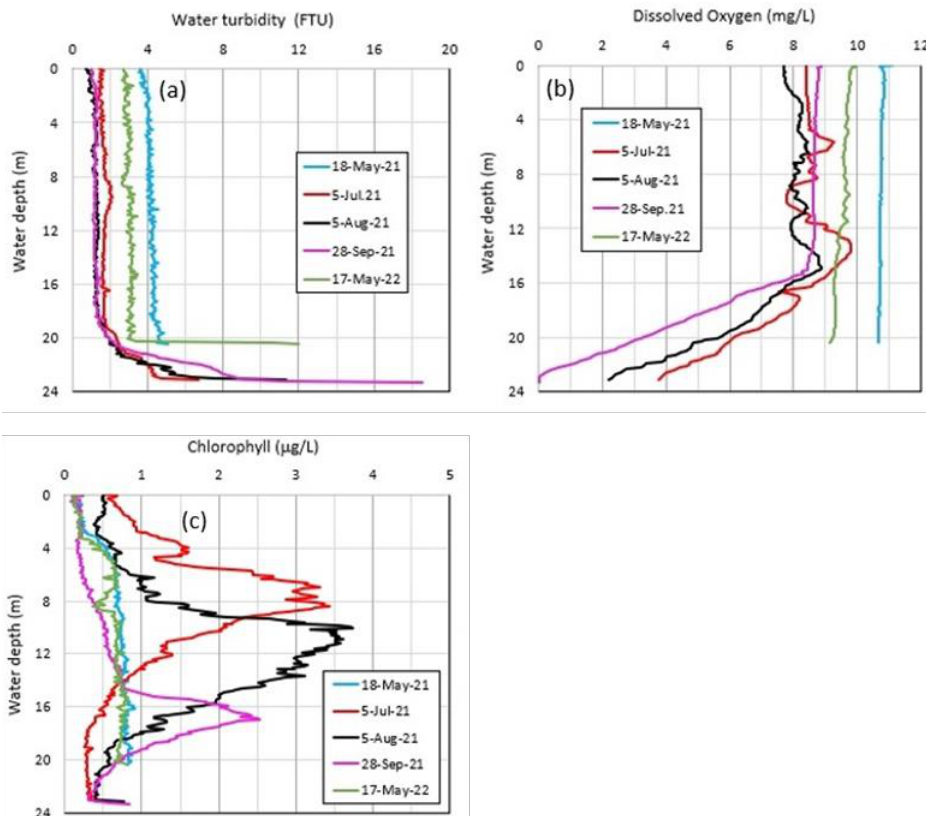
Figure 10. Vertical distributions of ( a ) water turbidity, ( b ) dissolved oxygen (DO), and ( c ) chlorophyll at site MD in May 2021 – May 2022.